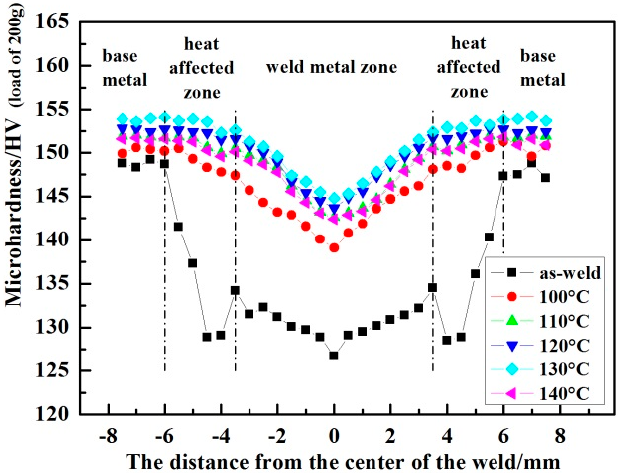
Figure 5. Microhardness distributions of welded joints aged at different temperatures for 24 h.